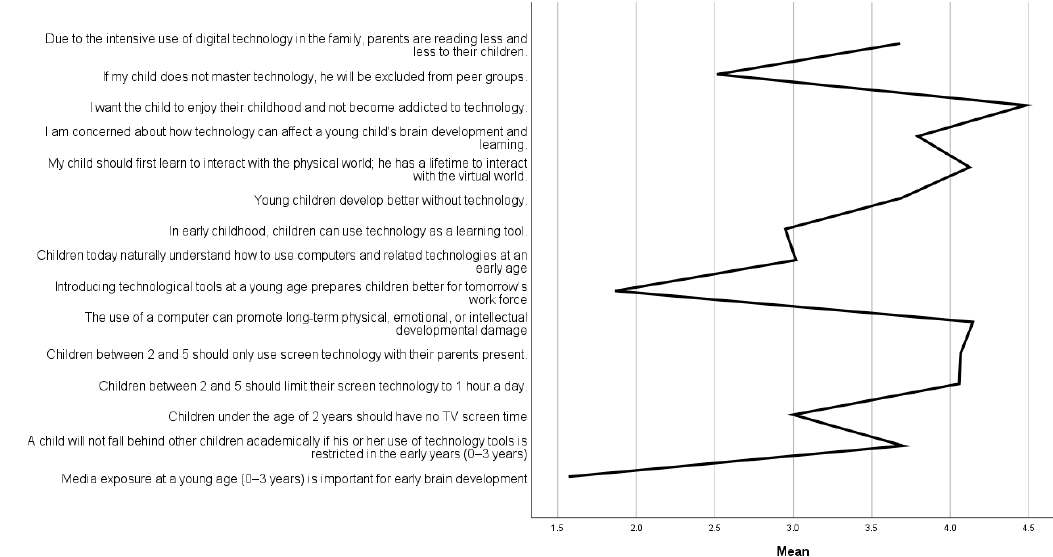
Figure 1. Parents’ attitudes towards digital technology in child’s development and learning.